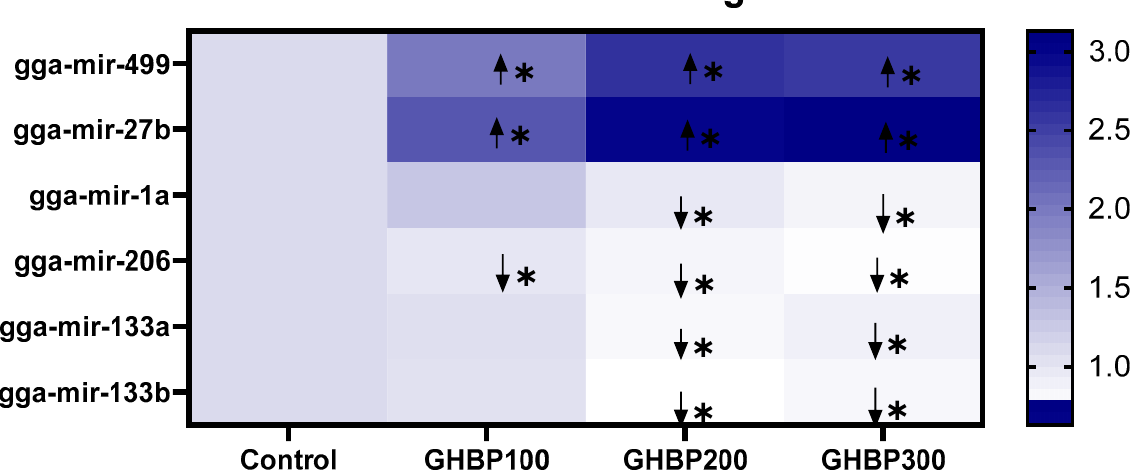
Figure 3. Heat map for expression of myomiRs (miRs-1a, 133a, 133b, 27b, and 499) in broiler chickens supplied with GHBP at day 38 of age. GHBP: growth hormone-boosting peptide. Data are expressed as means ± SE. Bars with different letters above them correspond to values that were significantly different ( p < 0.05). Control: basal diet without GHBP; GHBP100: basal diet plus GHBP at a level of 100 µ g/kg; GHBP200: basal diet plus GHBP at a level of 200 µ g/kg; GHBP300: basal diet plus GHBP at a level of 300 µ g /kg. * Squares correspond to values that are significantly different. Other squares with no (*) denote no significant changes in of miRNA expression among the experimental groups. Correspond to upregula- tion of miRNA expression relative to the control group ( p < 0.05). Correspond to downregulation of miRNA expression relative to control group ( p < 0.05).